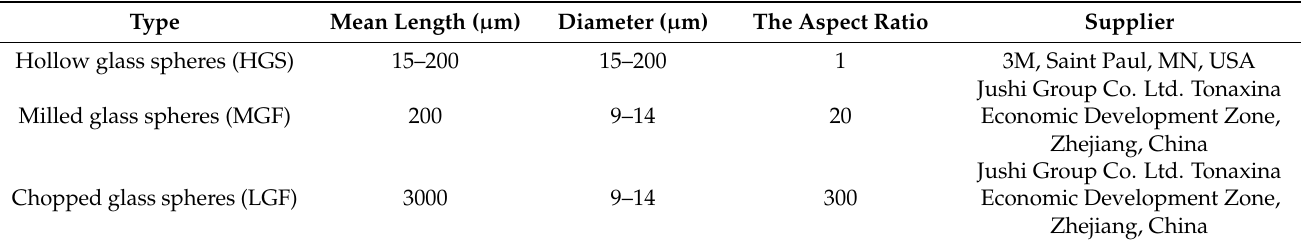
Figure 1. Scanning electron microscopy (SEM) micrographs of the materials: ( a ) Ultra-high molecular weight polyethylene (UHMWPE); ( b ) high density polyethylene grafted with VinylTriMethoxySilane (HDPE-g-VTMS); ( c ) polypropylene (PP); ( d ) hollow glass spheres (HGS); ( e ) milled glass fibers (MGF); ( f ) chopped glass fiber (CGF). Table 1. The fillers used for the fabrication of the